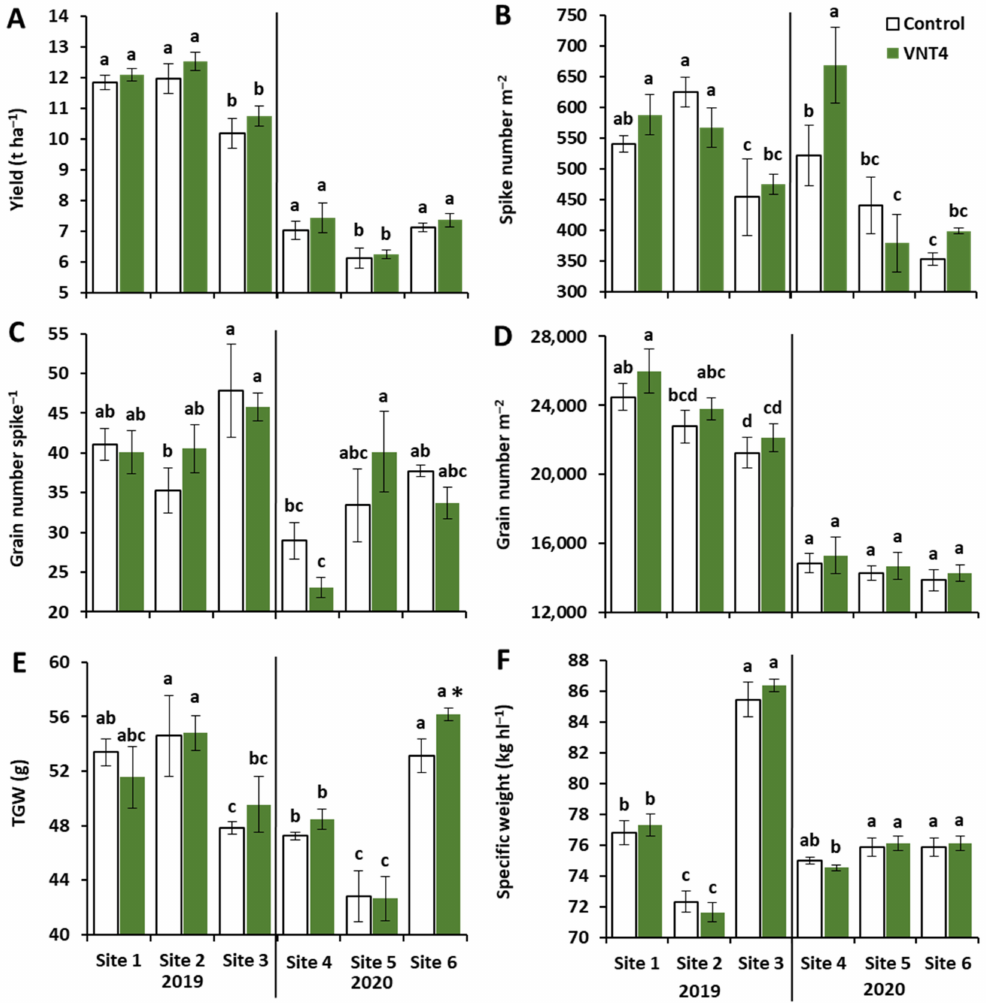
Figure 1. Influence of VNT4 on yield and its components in winter wheat under different site and year conditions. ( A ) Yield, ( B ) spike number per square metre, ( C ) grain number per spike, ( D ) grain number per square metre, ( E ) thousand grain weight (TGW) and ( F ) specific weight. Plant culture was carried out under six different field conditions in France, Normandy. N was provided at the tillering, stem elongation and flag leaf stages. 5 L ha − 1 of VNT4 formulation (see Table 1 for more details) were mixed with UAN before each N application, leading to a global application of 15 L ha − 1 . Bars indicate means ± SE. Different letters denote significant differences in 2019 or 2020 according to Fisher’s test ( p < 0.05; n = 3 in 2019, n = 4 in 2020) and star denote significant differences between control and VNT4 according to a pairwise comparison (Fisher’s test, *; p < 0.05, n =